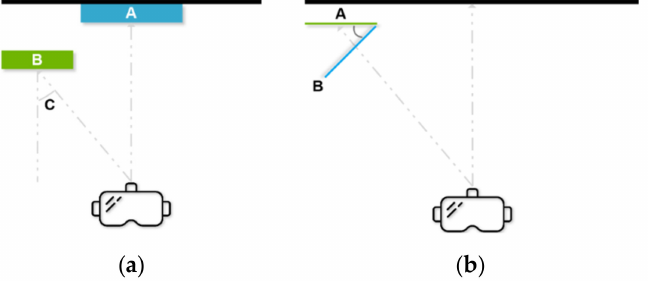
Figure 4. XR 3D layout: ( a ) Traditional 3D layout [9]; ( b ) User view limitation and solution